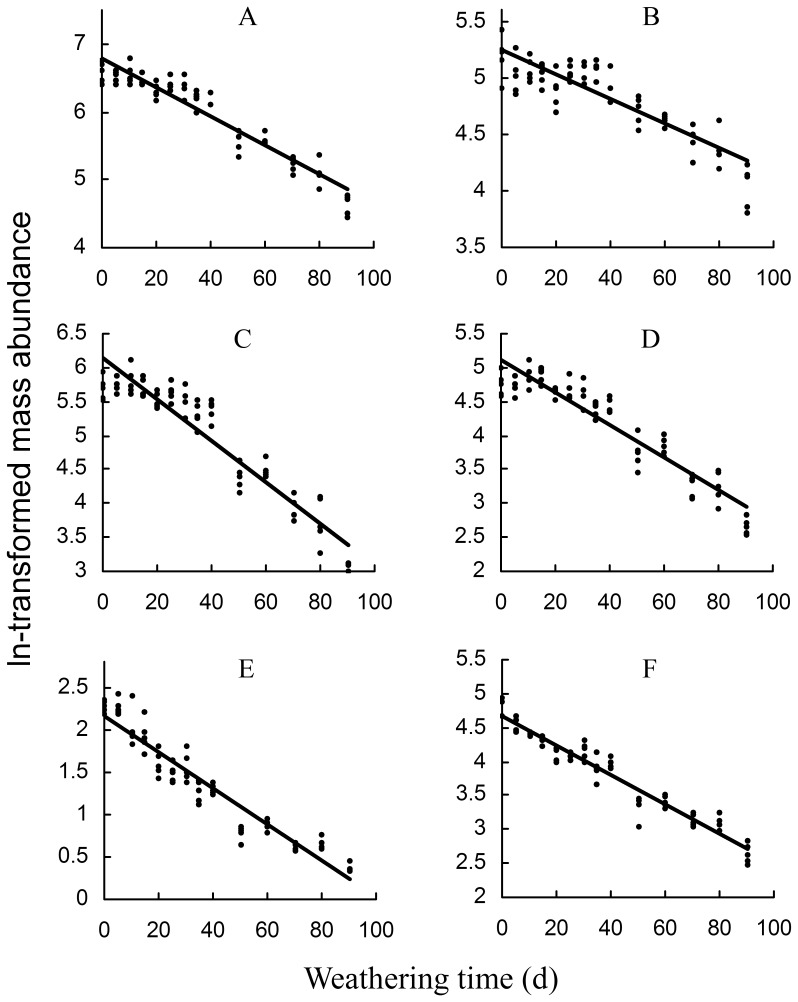
Time-dependent decreases in ln-transformed mass abundance of various classes of puparial hydrocarbons during the 90-day weathering process in Chrysomya megacephala (P<0.05).The corresponding functions were: A, total hydrocarbon, y = −0.0215x+6.8009, r2 = 0.9019; B, normal alkane, y = −0.0107x+5.2353, r2 = 0.7448; C, monomethyl alkane, y = −0.0306x+6.1457, r2 = 0.8865; D, dimethyl alkane, y = −0.023x+4.9965, r2 = 0.8814; E, Alkene, y = −0.0326x+3.2289, r2 = 0.9063; F, other unidentified lipids, y = −0.0217x+4.7088, r2 = 0.9388.